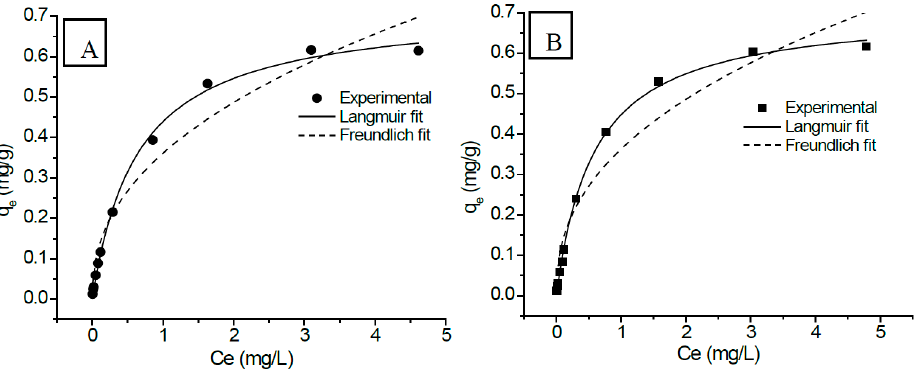
Figure 10. Isotherms of equilibrium adsorption of As (V) on ( A ) Ch–Rs and ( B ) Ch–Pu blends. Table 3. Isotherm parameters of the adsorption of As (V) on Ch–Rs and Ch–Pu blends. Isotherm